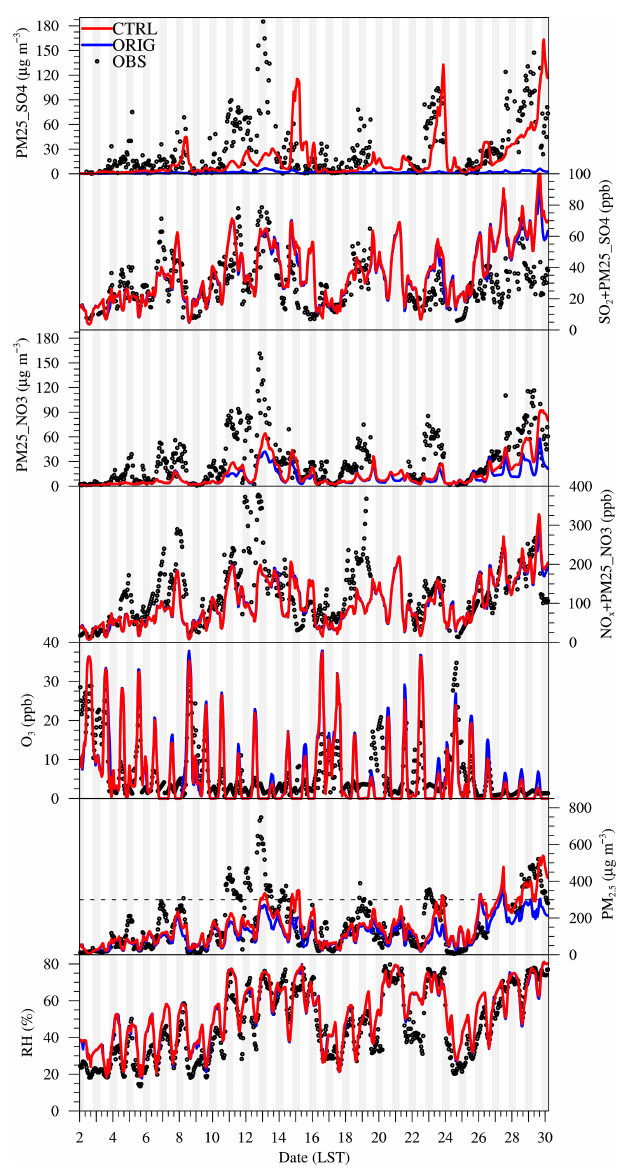
Figure 1. Comparison of hourly model results and observations (OBS) for ORIG and CTRL scenarios at the Beijing TSU site during January 2013. The compared parameters include modeled hourly concentrations of fine particulate sulfate (PM25_SO4), the sum of SO 2 and PM25_SO4 (PM25_SO4 converted to the equivalent vol- ume mixing ratio of SO 2 ), fine particulate nitrate (PM25_NO3), the sum of NO x and PM25_NO3 (PM25_NO3 converted to the equiva- lent volume mixing ratio of NO x ), O 3 , and PM 2 . 5 , as well as hourly relative humidity